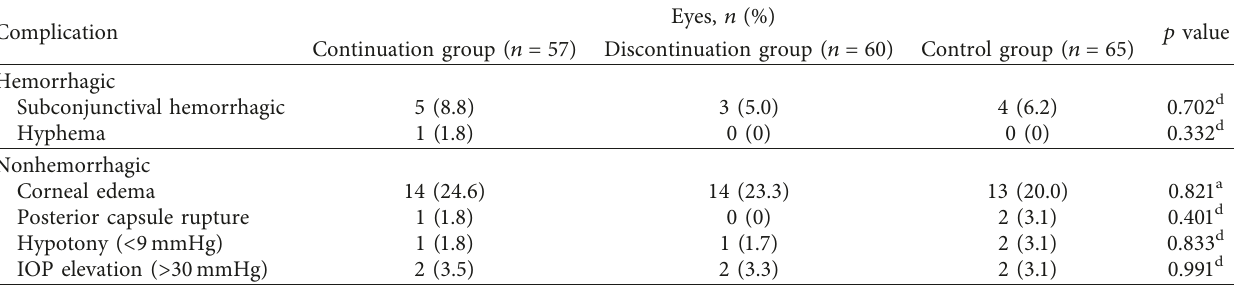
Table 6: Incidence of complications in clear corneal incision